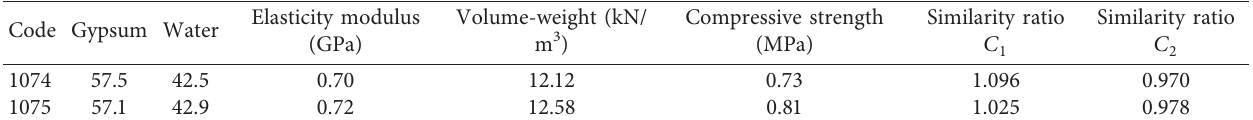
Table 5: Mechanical properties of the different segment and similarity ratios [14]. Code Gypsum